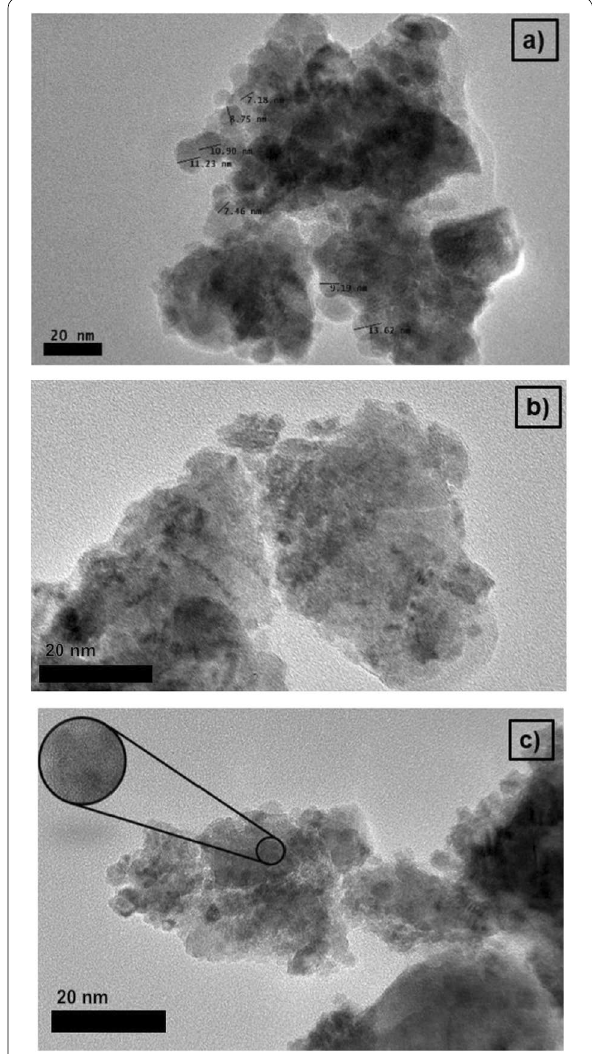
Fig. 3 HRTEM images with a 20-nm scale bar of MNA at a 3 h b 5